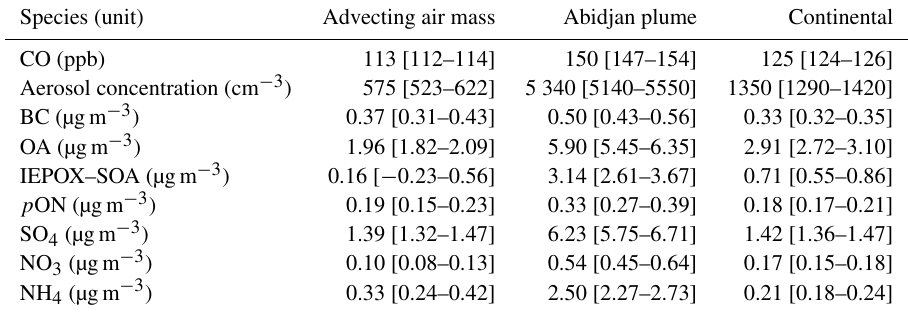
Table 1. Mean and lower and upper 95% confidence interval of mean for different species at the flight transects shown in Fig.